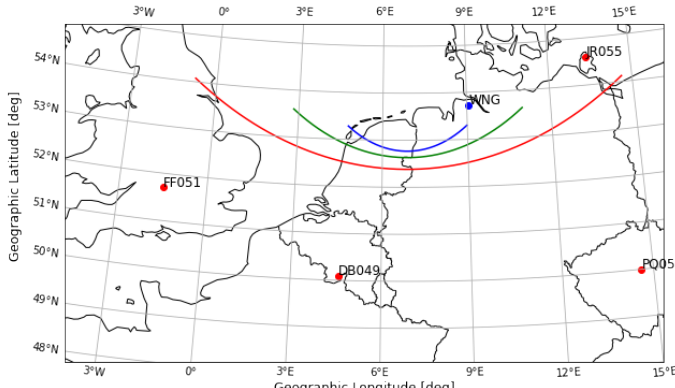
Figure 11. Location of LOFAR pierce points (at 200, 400 and 800 km altitude marked with blue, green and red line, respectively) relative to the observatories used in the analysis. Red dots: stations that serve as a source of ionospheric plasma drift data; geomagnetic field data were obtained from the stations WNG and DOU (marked as DB049).